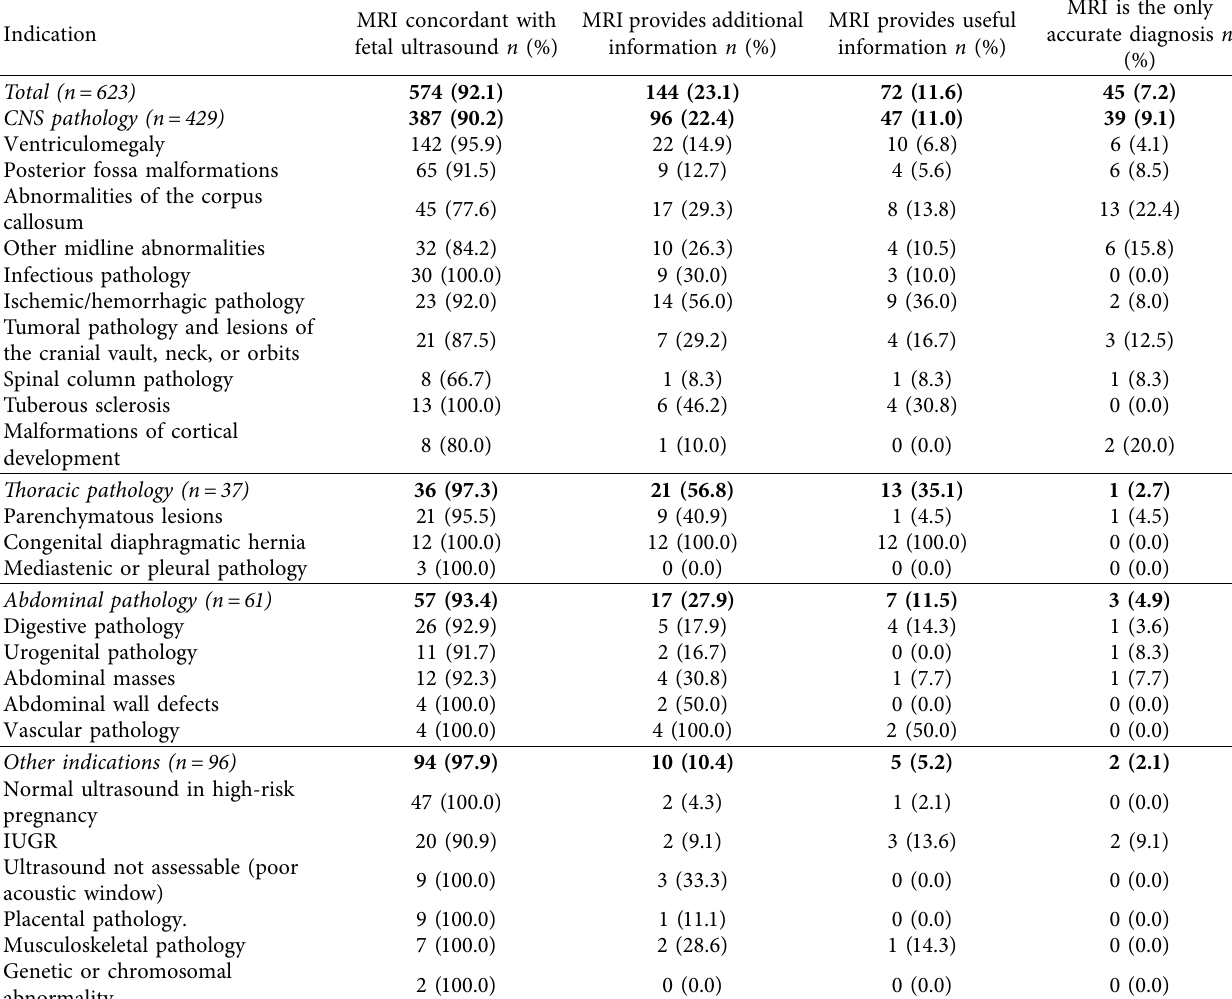
Table 5: Usefulness of fetal magnetic resonance as a complementary procedure to fetal ultrasound in the 623 cases referred between January 2007 and December